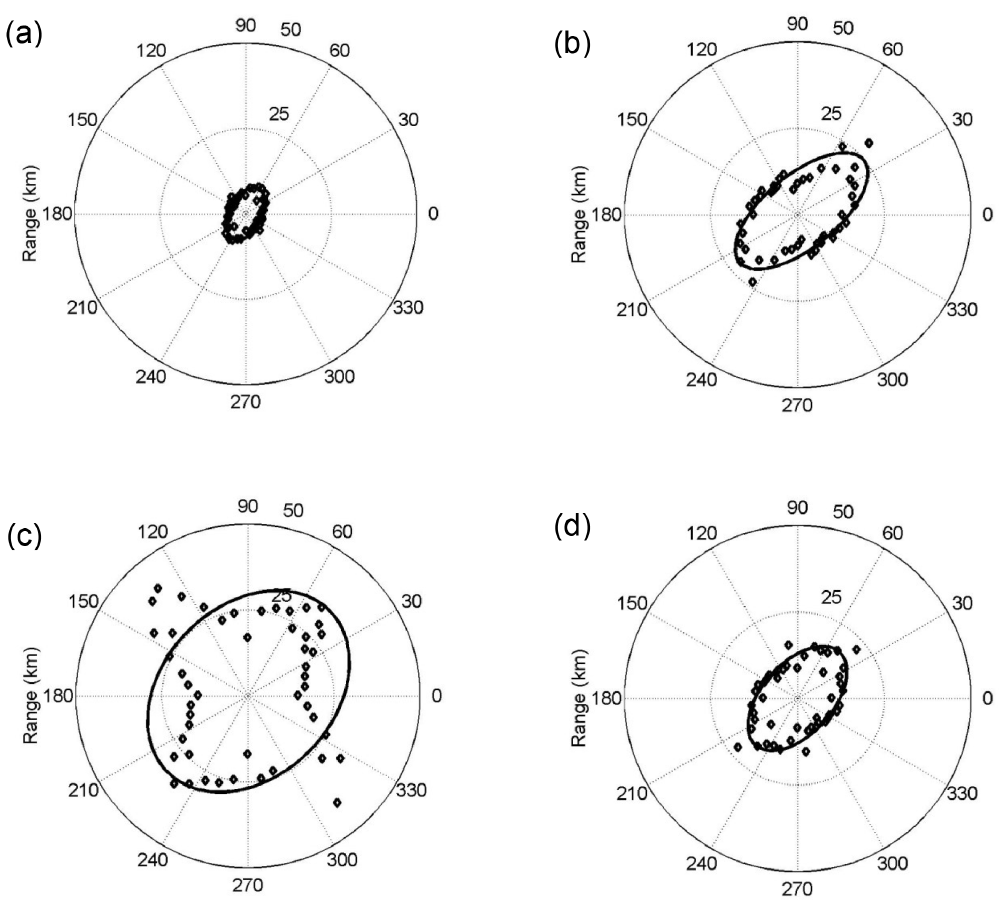
Figure 16. Range values for (a) the 18 May 2007 storm (16:30LT), (b) the 19 May 2007 storm (16:00LT), (c) the 19 April 2008 storm (20:00LT), and (d) the 15 September 2009 storm (15:00LT; modified from Liu, 2013).